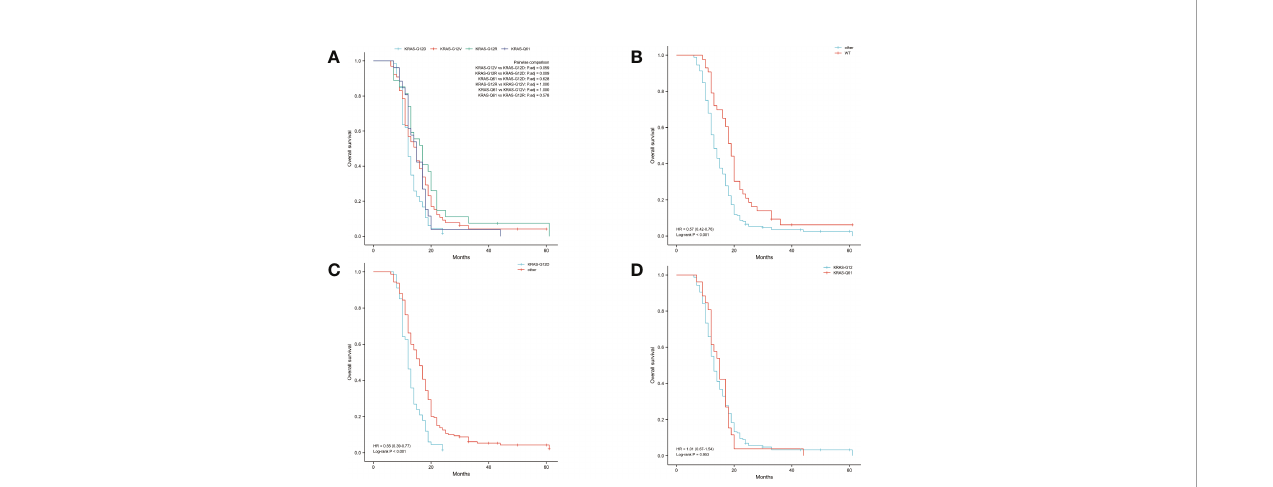
FIGURE 2 Overall survival (OS) in all patients was examined with Kaplan-Meier plots and log-rank tests. (A) Comparison of four groups (KRAS-G12D, KRAS- G12V, KRAS-G12R, KRAS-Q61) with KRAS mutations. (B) Comparison of patients with KRAS wild-type and those with KRAS mutations. Other groups included KRAS-G12D, KRAS-G12V, KRAS-G12R, and KRAS-Q61. (C) Intercomparison between patients with KRAS-G12D mutation and other patients. Other groups included KRAS wild-type, KRAS-G12V, KRAS-G12R, and KRAS-Q61. (D) Examination of mutations at codons 12 and 61. KRAS-G12D, KRAS-G12V, and KRAS-G12R were all part of the codon 12 group of KRAS. The KRAS-Q61 family consisted of four different variants (KRAS-Q61H, KRAS-Q61R, KRAS-Q61K, and KRAS-Q61L). WT, KRAS wild-type; HR, hazard ratio; The numbers in parentheses represent 95% con fi dence